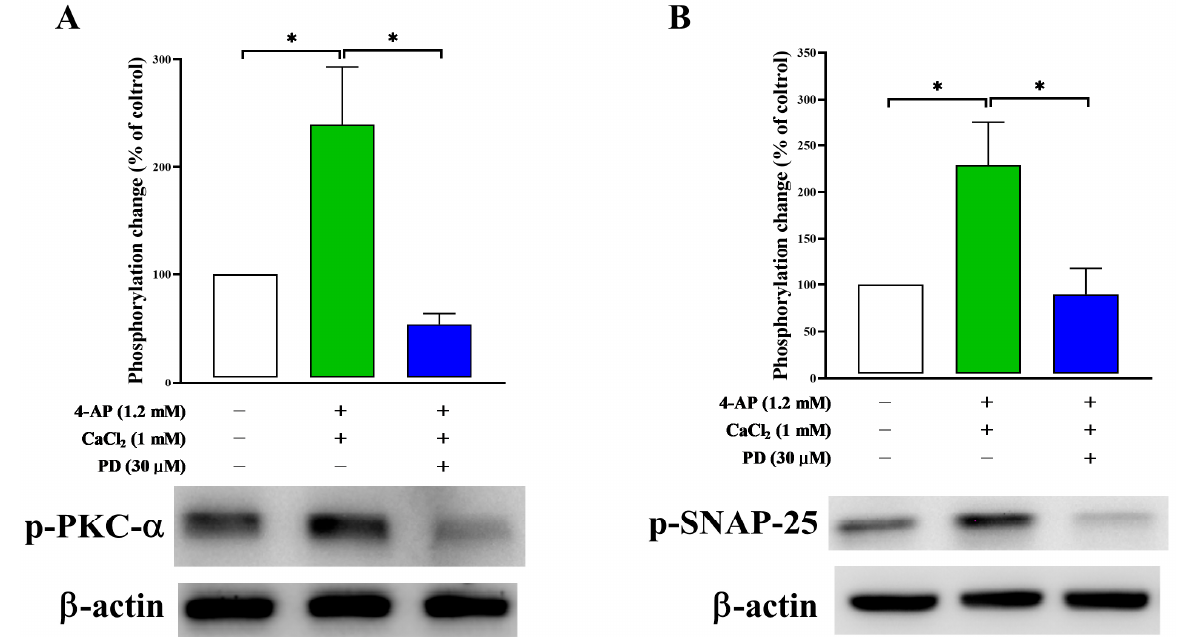
Figure 8. Effect of PD on 4-AP-evoked phosphorylation of PKC- α ( A ) and SNAP-25 ( B ), which is a target of PKC. PD was added 10 min before depolarization with 4-AP. The phosphorylation level was measured at 10 min after 4-AP depolarization and expressed as a percentage of that measured in the control group without 4-AP. Each bar represents the means ± SEMs of the results obtained in 3 experiments ( n = 3 per group). * p < 0.05 versus the control or 4-AP-treated group.